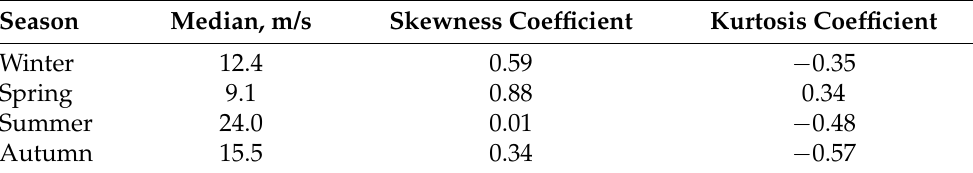
Figure 3. The probability distributions of the wind speed at the 125 hPa level at the site of the Nha Trang observatory. Table 1. Statistics of the wind speed at the 175 hPa pressure level at the Nha Trang